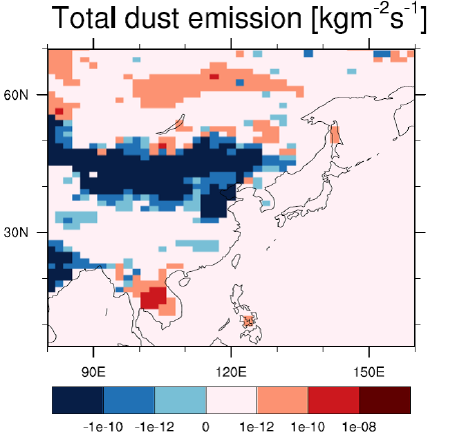
Figure 15. Future changes in total dust emission (kgm − 2 s − 1 ) in JJA from AEts −